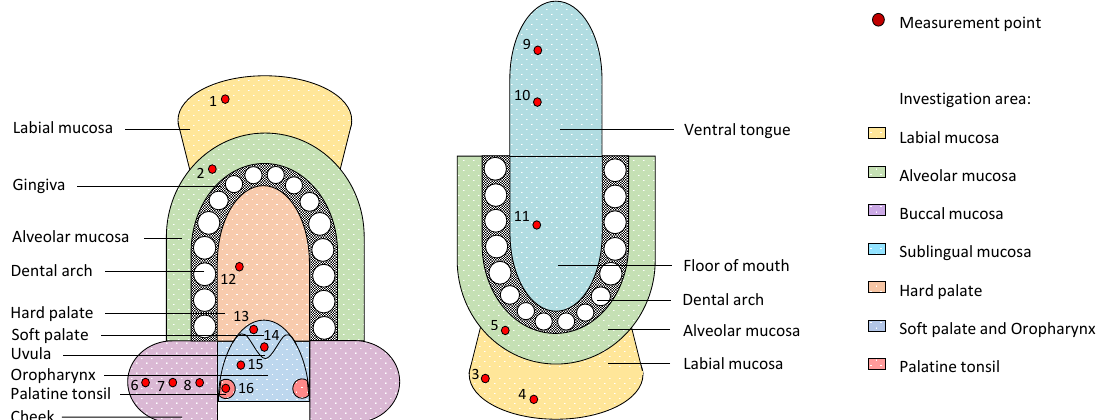
Figure 1. Schematic illustration of the human oral cavity with seven investigation areas (colored zones) and selected measurement points (red dots) in consideration of common sites of oral